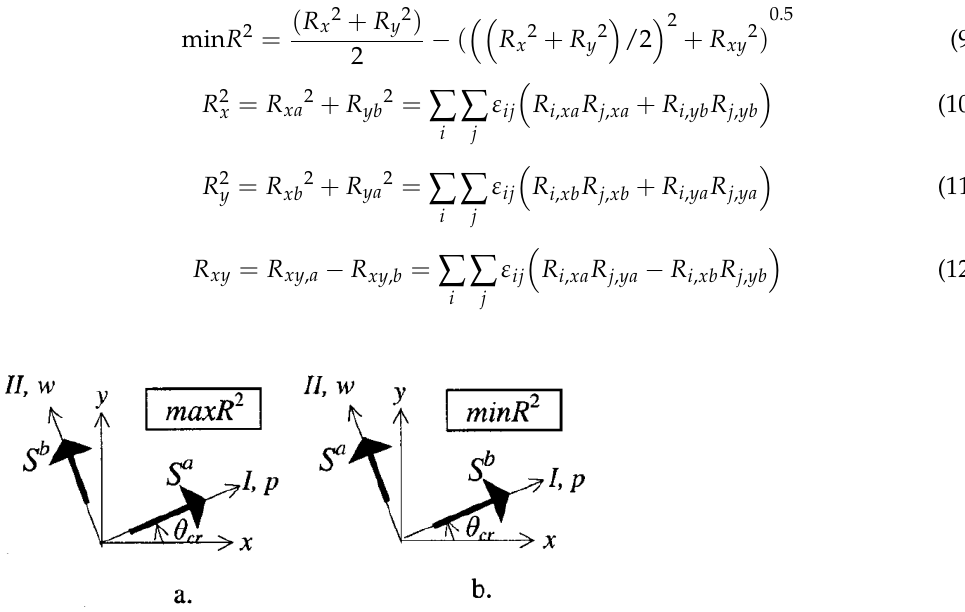
(7) max (cid:1844) (cid:2870) (cid:3404) (cid:4666)(cid:1844) (cid:3051)(cid:2870) (cid:3397) (cid:1844) (cid:3052)(cid:2870) (cid:4667) 2 (cid:3397) (cid:4666)(cid:4666)(cid:4666)(cid:1844) (cid:3051)(cid:2870) (cid:3397) (cid:1844) (cid:3052)(cid:2870) (cid:4667)/2(cid:4667) (cid:2870) (cid:3397) (cid:1844) (cid:3051)(cid:3052)(cid:2870) (cid:4667) (cid:2868).(cid:2873)